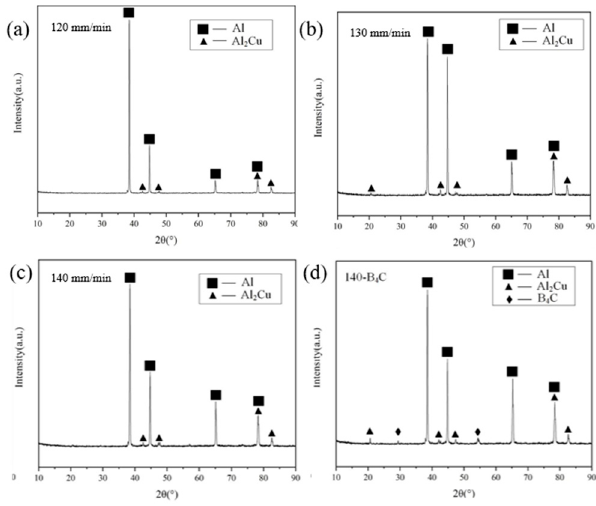
Figure 5. XRD analysis of different deposition rates ( a ) 120 mm/min, ( b ) 130 mm/min, ( c ) 140 mm/min, ( d ) 140 mm/min-B 4 C.